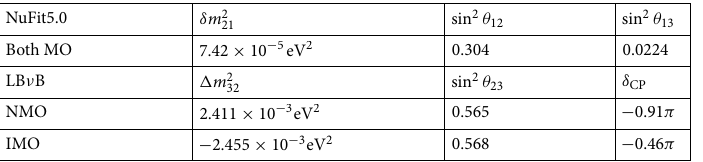
Table 1. In this work, the neutrino oscillation parameters are reduced to the latest values obtained in the NuFit5.0 21 , where (cid:31) m 2 32 , sin 2 θ 23 and δ CP (last two rows) were obtained by using only LB ν B experiments by fixing δ m 2 21 , sin 2 θ 12 and sin 2 θ 13 to the values shown in this table (second row).